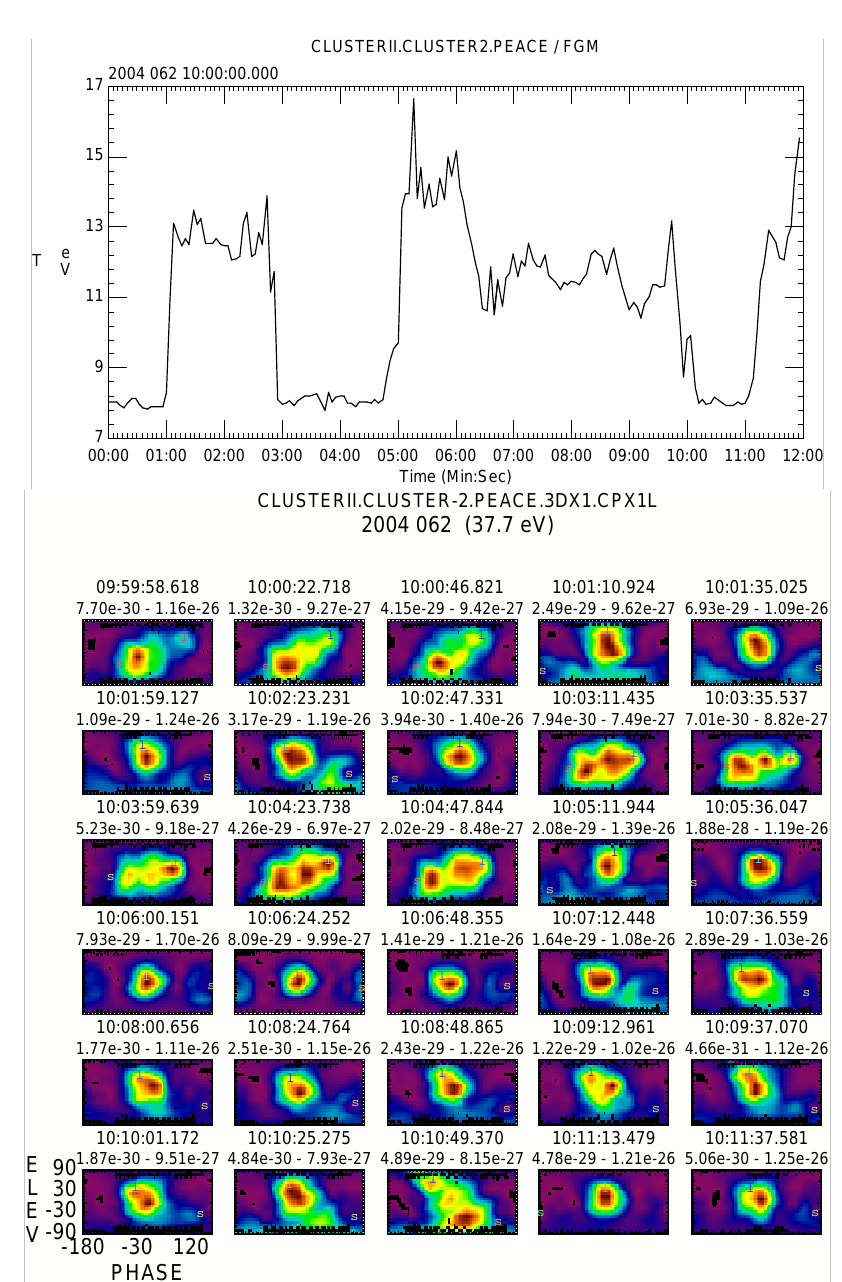
Fig. 6. Comparison between eVDFs inside and outside the foreshock showing that scattering is seen only outside the foreshock. Upper plot shows the electron temperature over a 12min time frame. The spacecraft are in the foreshock during times that the electron temperature is off the baseline value of about 8eV. The lower plot shows a time series of PT plots at a fixed energy of 37.7eV. The PT plots are not sequential in time having a 24s cadence. Scattering is seen to occur only during the times when the temperature is at its baseline